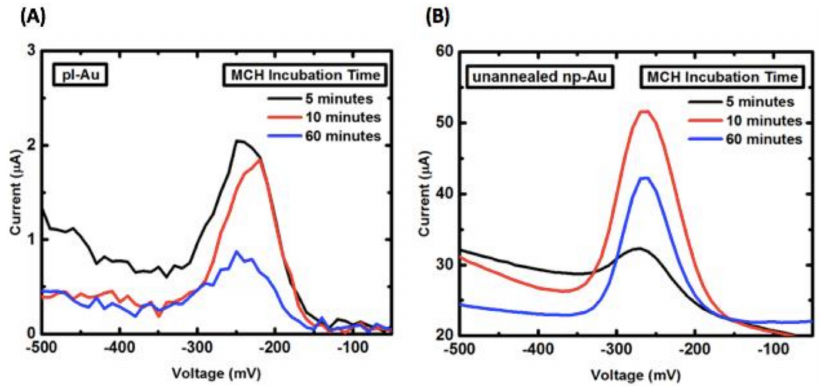
Figure A8. Influence of mercaptohexanol (MCH) incubation duration on the probe current for ( A ) pl-Au and ( B ) np-Au electrodes. For both morphologies optimal MCH incubation duration ranges between 10 to 60 min.